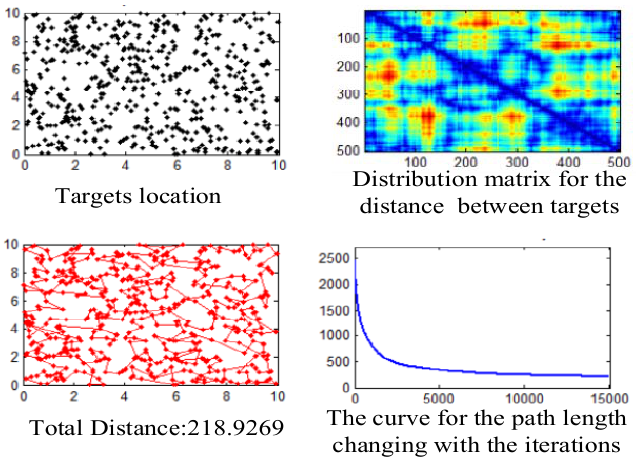
Figure 9. The results for the path planning between 500 targets.